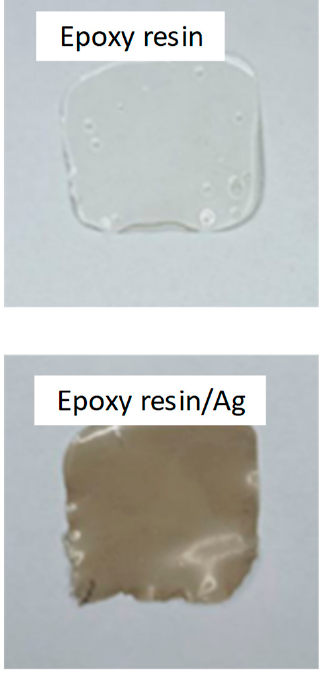
Figure 5. The study of the Ag nanoparticles thermal properties: ( a ) the photographs of the Ag-free and Ag-containing samples of the epoxy resin, ( b ) the corresponding thermal images of the samples after the LED projector exposure for 30 min.